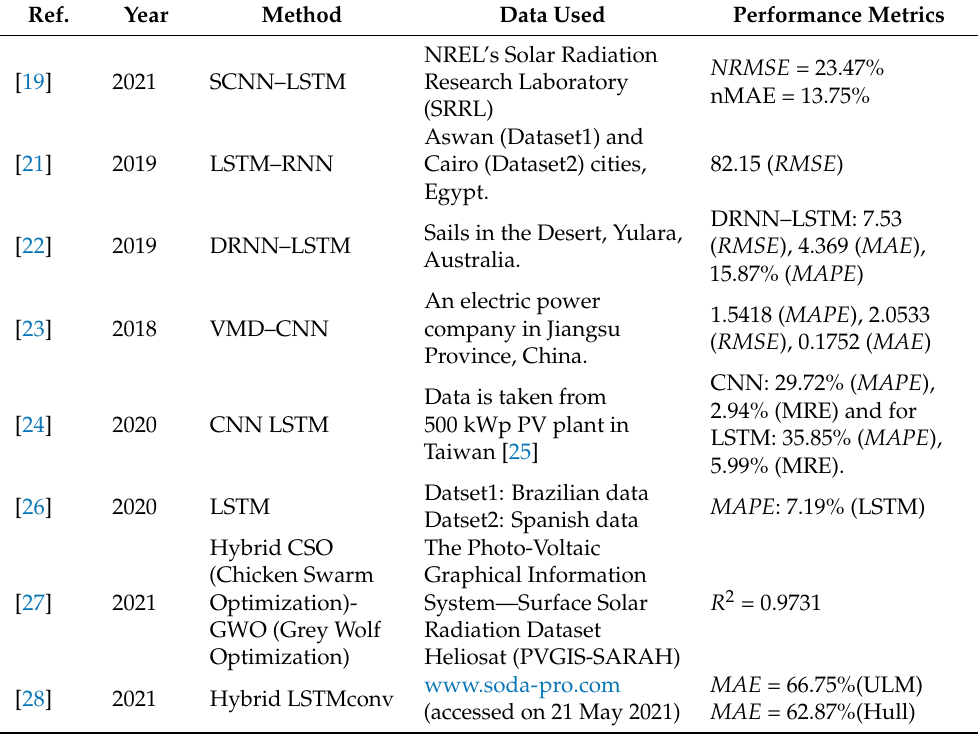
Table 1. Bibliographic analysis using DL for solar forecasting.